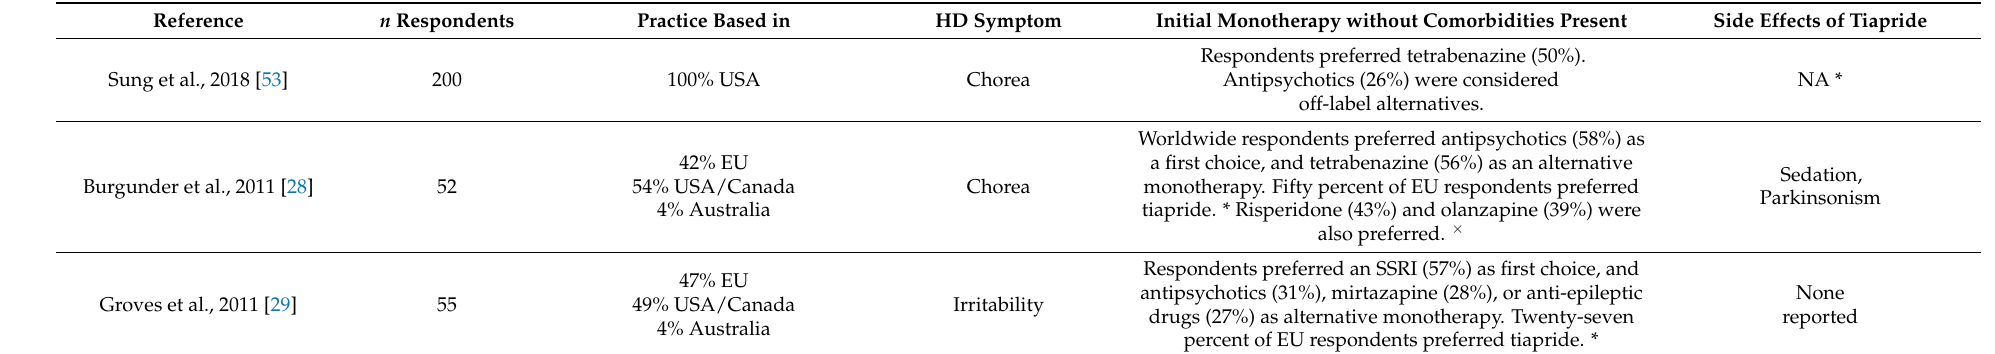
Table 2. Summary of included expert